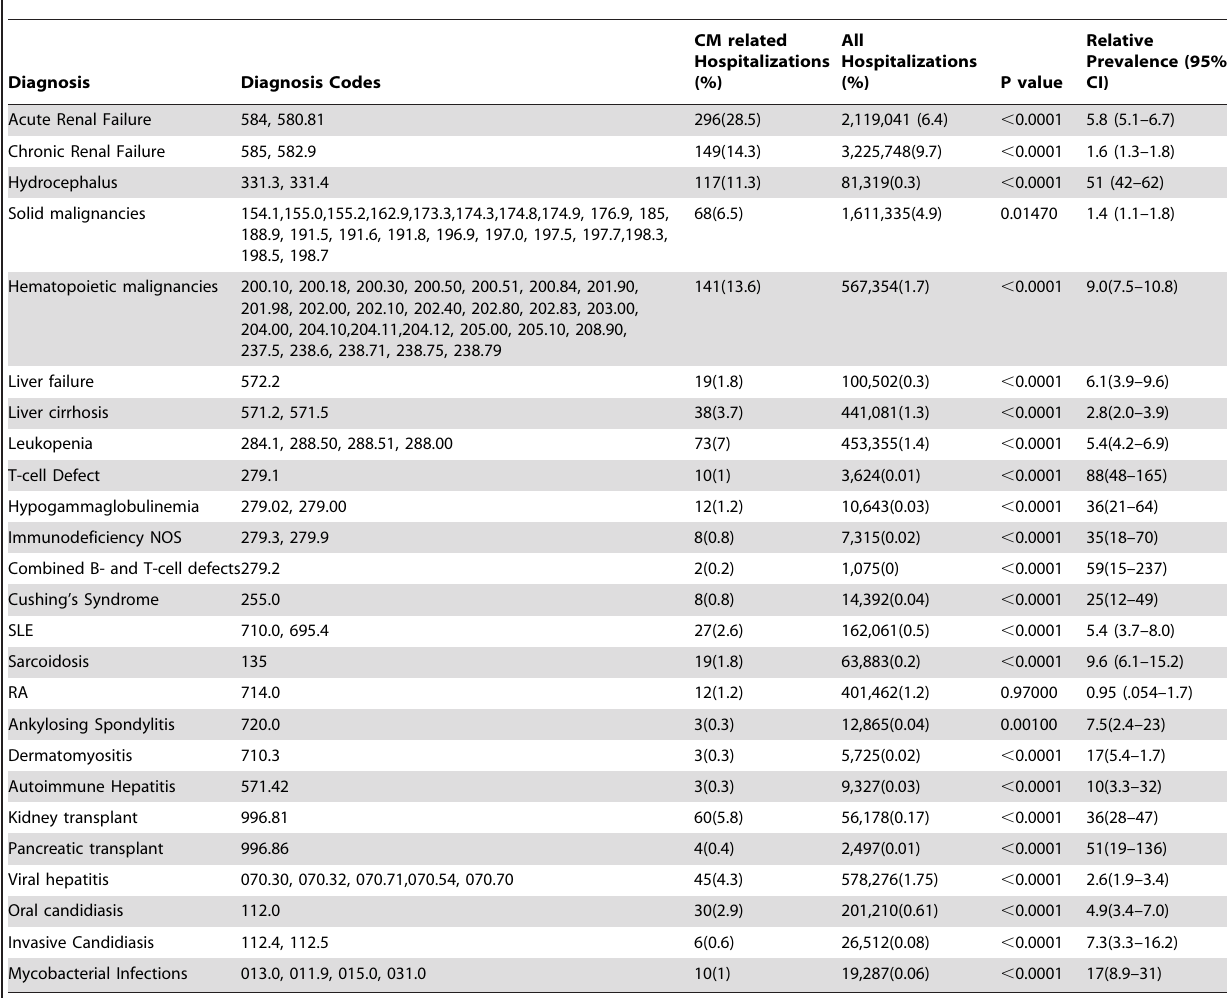
Table 1. Relative incidence of selected co-morbid conditions among CM hospitalizations compared to all-cause hospitalizations.